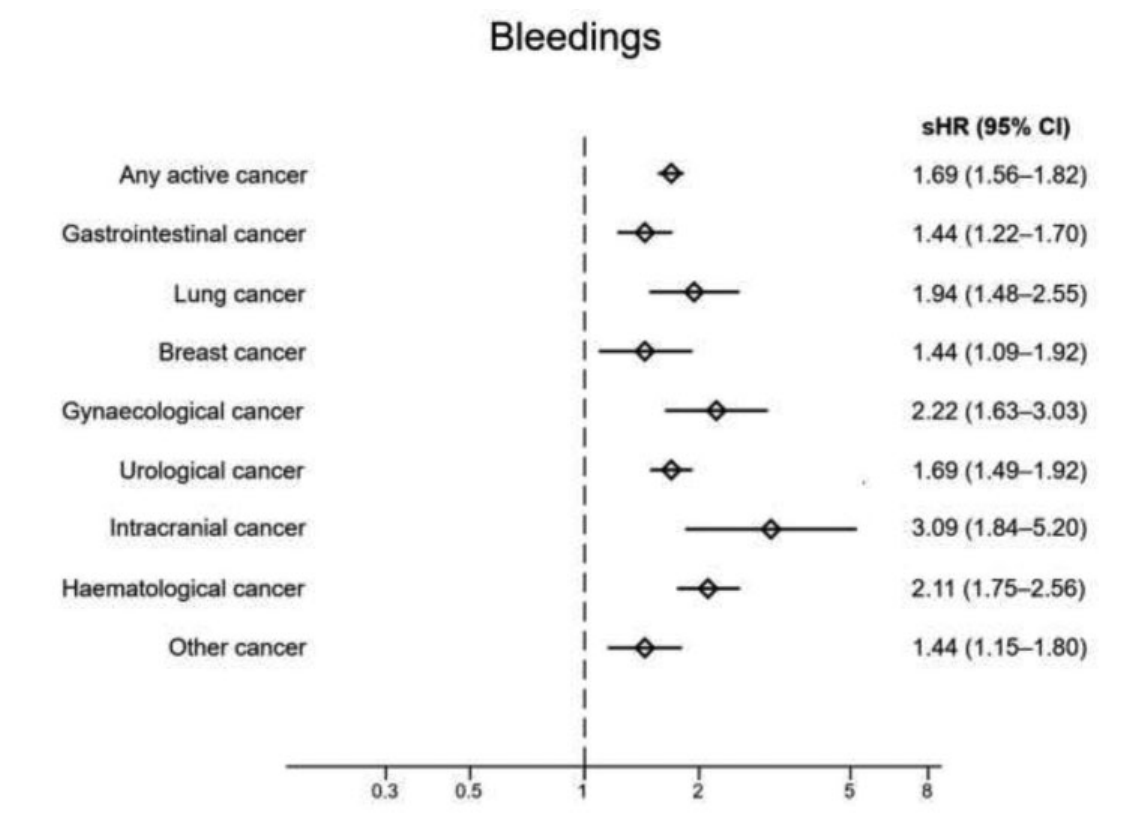
TH Open Vol. 5 No. 2/2021 © 2021. The